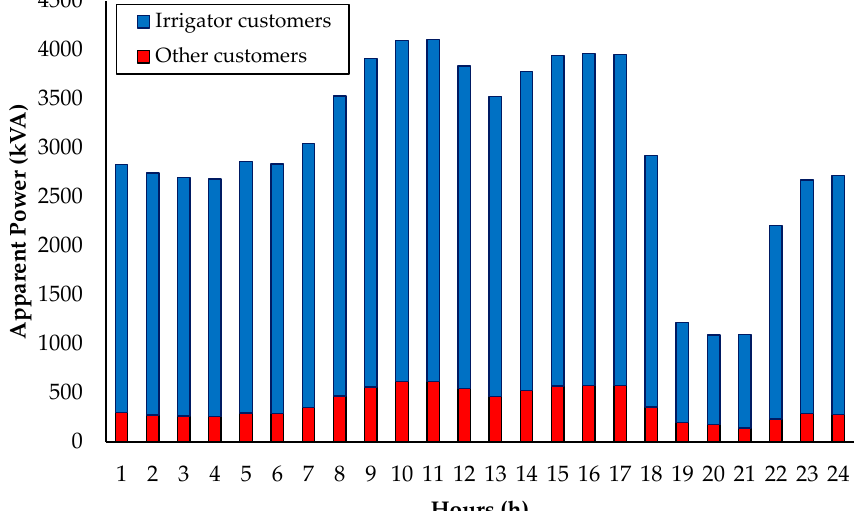
Figure 11. Load distribution on Rural Feeder A. Source: The authors.